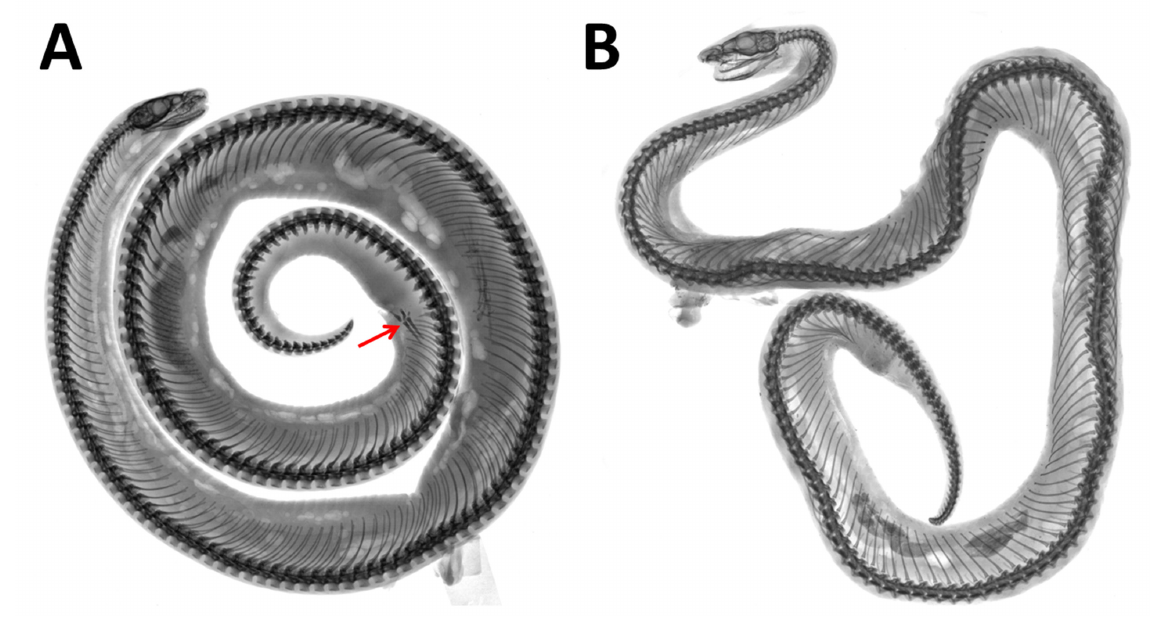
Fig. 8. X-ray images of Tropidophis cacuangoae sp. nov. A . ♂, holotype (DHMECN 16725). B . ♀, paratype (DHMECN 15893). The red arrow shows the pelvic remnants of the male specimen, which are absent in the